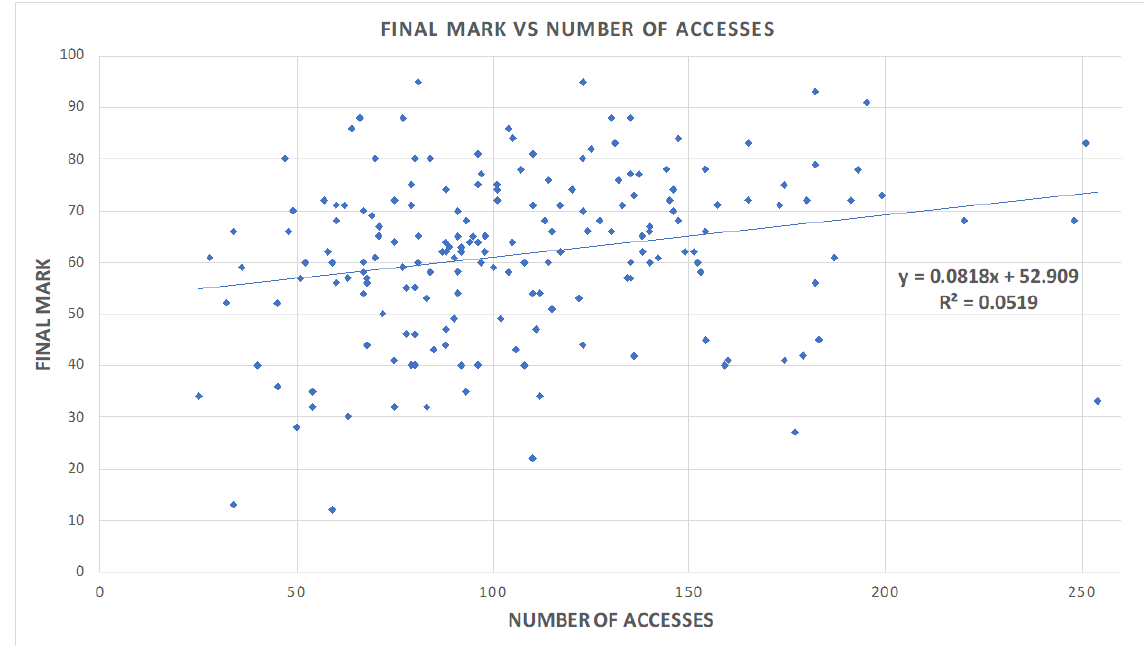
Figure 4 . Final Mark vs Number of Accesses